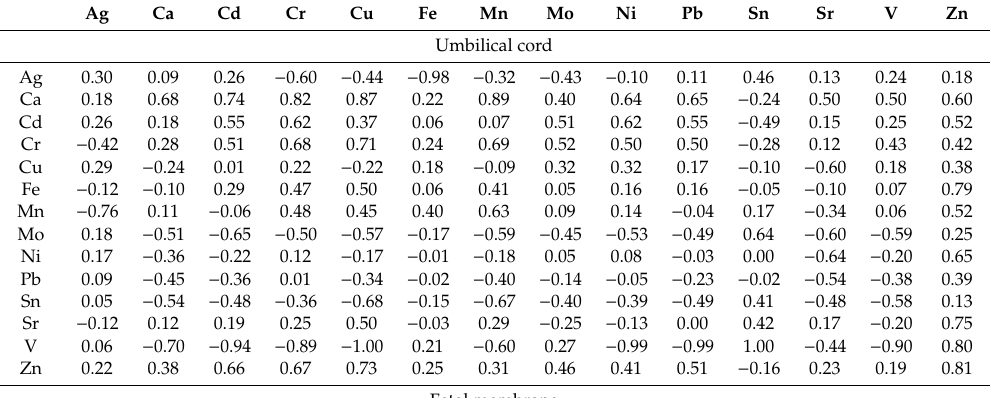
Table 4. Pearson’s correlation coe ffi cients between analyzed elements in the umbilical cord and fetal membrane ( p <